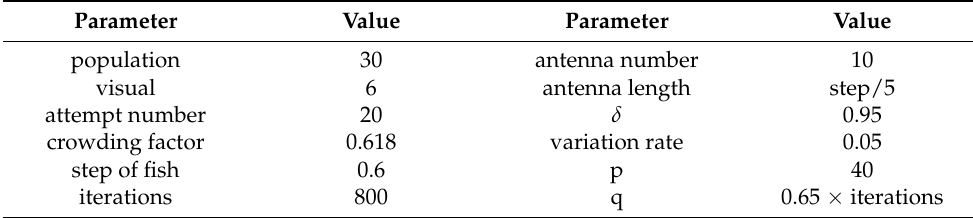
Table 4. Initial parameters of AFS-MMSBAS